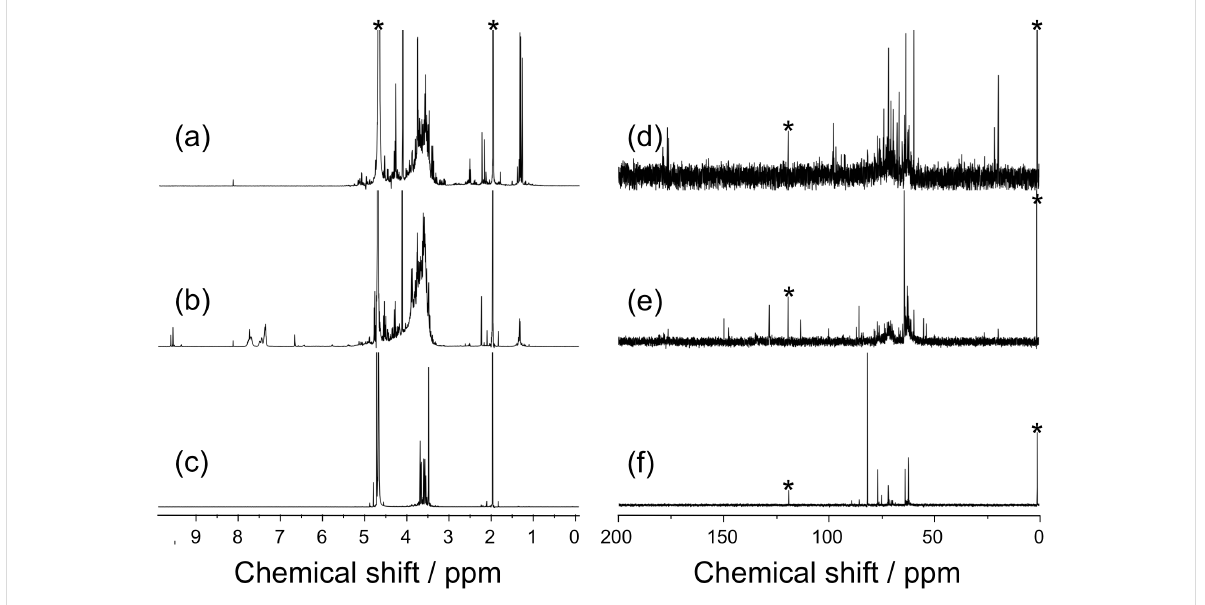
Figure 3: 1 H (a, b, and c) and 13 C NMR spectra (d, e, and f) for the products of the formose reaction in the absence (a and d) and presence of 10 mM SPB (b and e) and 20 g L − 1 pVPB/NaSS (c and f); the reaction times were 20, 90, and 180 min for (a and d), (b and e), and (c and f), respectively. Asterisks denote the signals of the internal standard, i.e., acetonitrile.